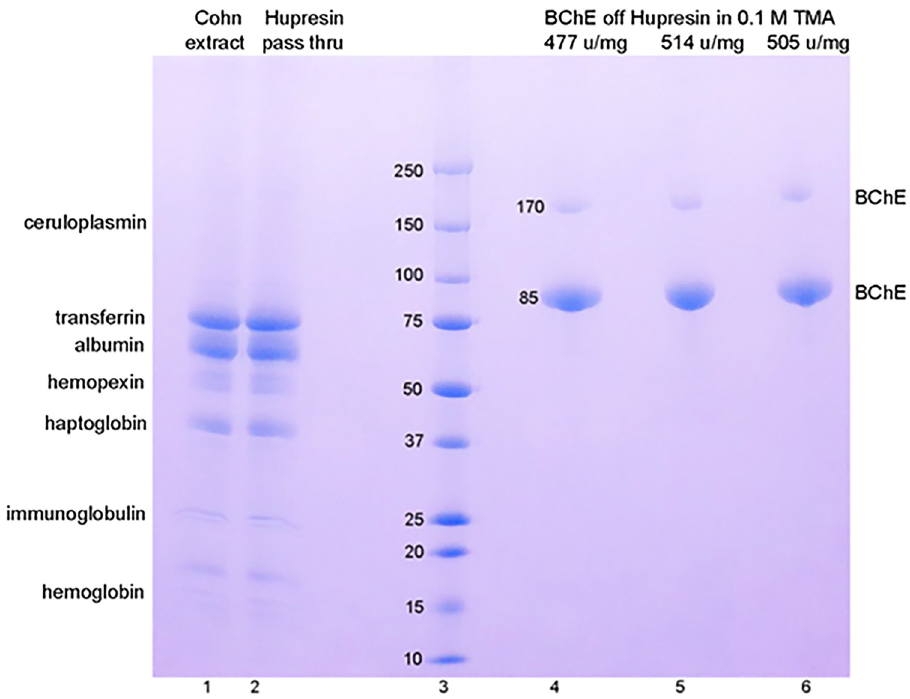
Fig 3. SDS polyacrylamide gel stained with Coomassie blue. Proteins were loaded at 5 μ g per lane. Lane 1 Cohn extract. Lane 2 Hupresin pass through. Lane 3 molecular weight markers. Lanes 4, 5, and 6 highly purified BChE eluted from Hupresin with 0.1 M tetramethylammonium bromide in 20 mM sodium phosphate pH 8. In the presence of dithiothreitol and SDS, the 340 kDa BChE tetramer dissociates into 85 kDa monomers and a nonreducible dimer at 170 kDa. The most abundant proteins in the Cohn paste extract are